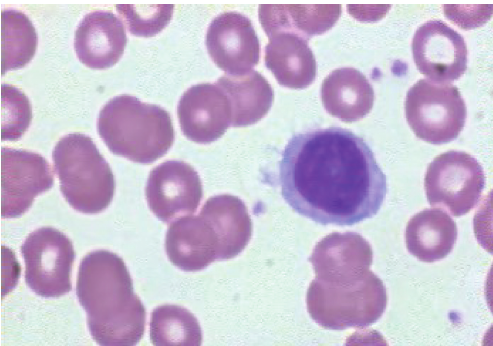
Figure 2: Peripheral blood smear showing an atypical lymphocyte with elongated cytoplasm